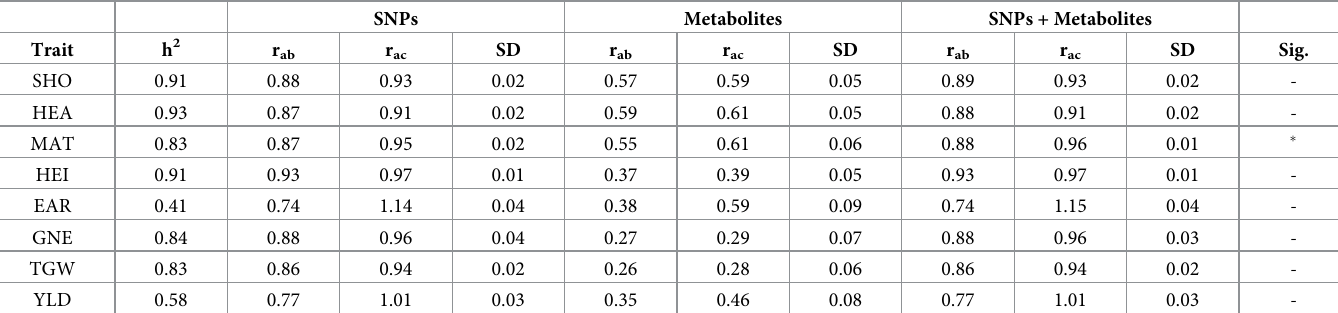
Table 2. Summary of genomic and metabolic prediction, BayesB model.